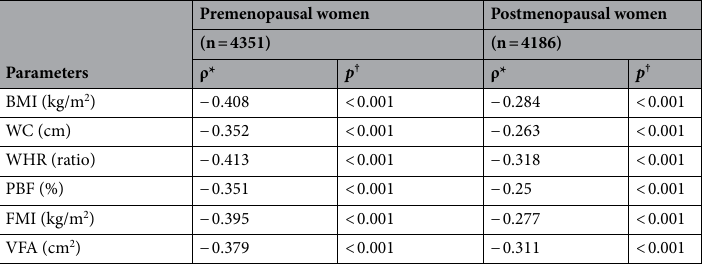
Table 3. Correlations between body fat parameters and grade of breast density. *Spearman’s rank correlation coefficient. † p values by nonparametric measure of correlation. BMI body mass index, WC waist